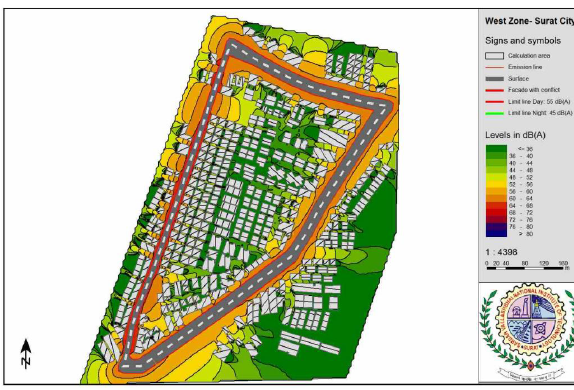
Figure 10: Night-time noise map of West zone using RLS-90